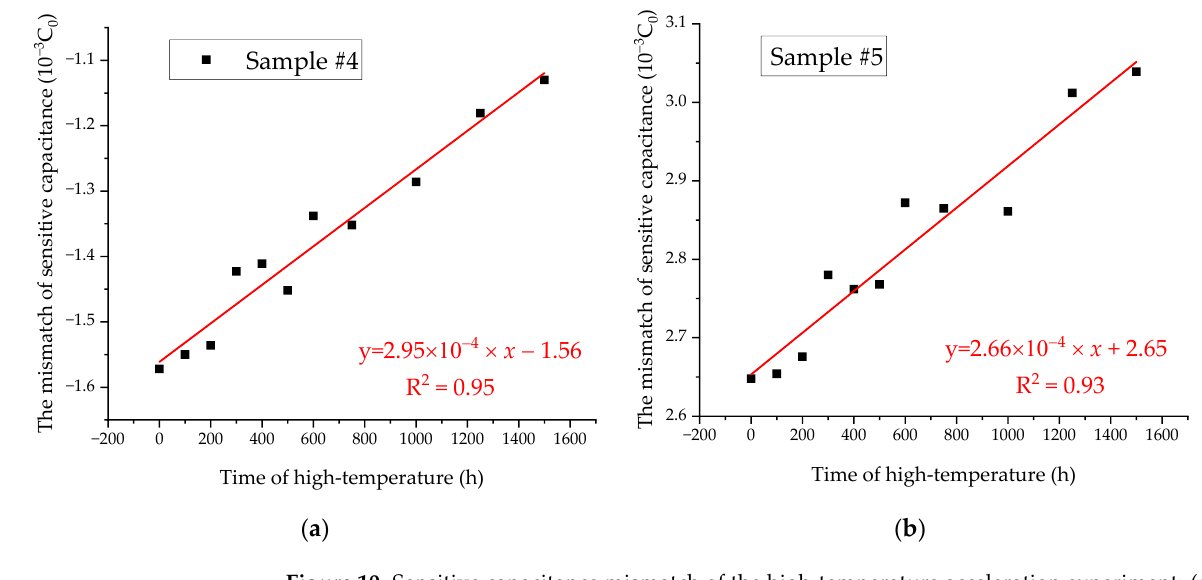
Figure 10. Sensitive capacitance mismatch of the high-temperature acceleration experiment: ( a ) Data of Sample #4; ( b ) Data of Sample #5.